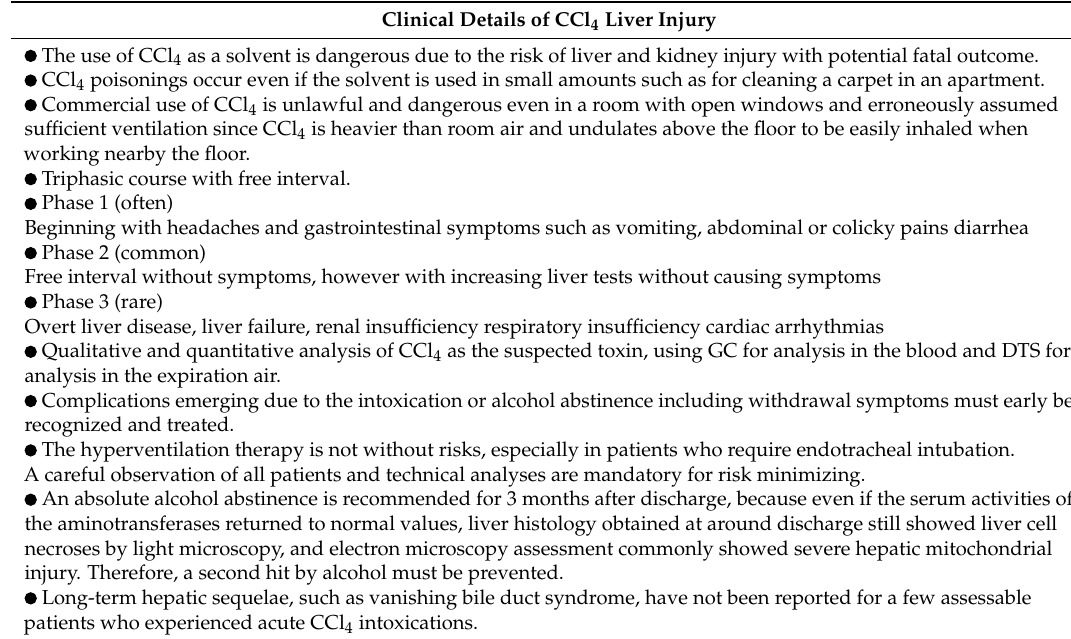
Table 8. Clinical characteristics of CCl 4 liver